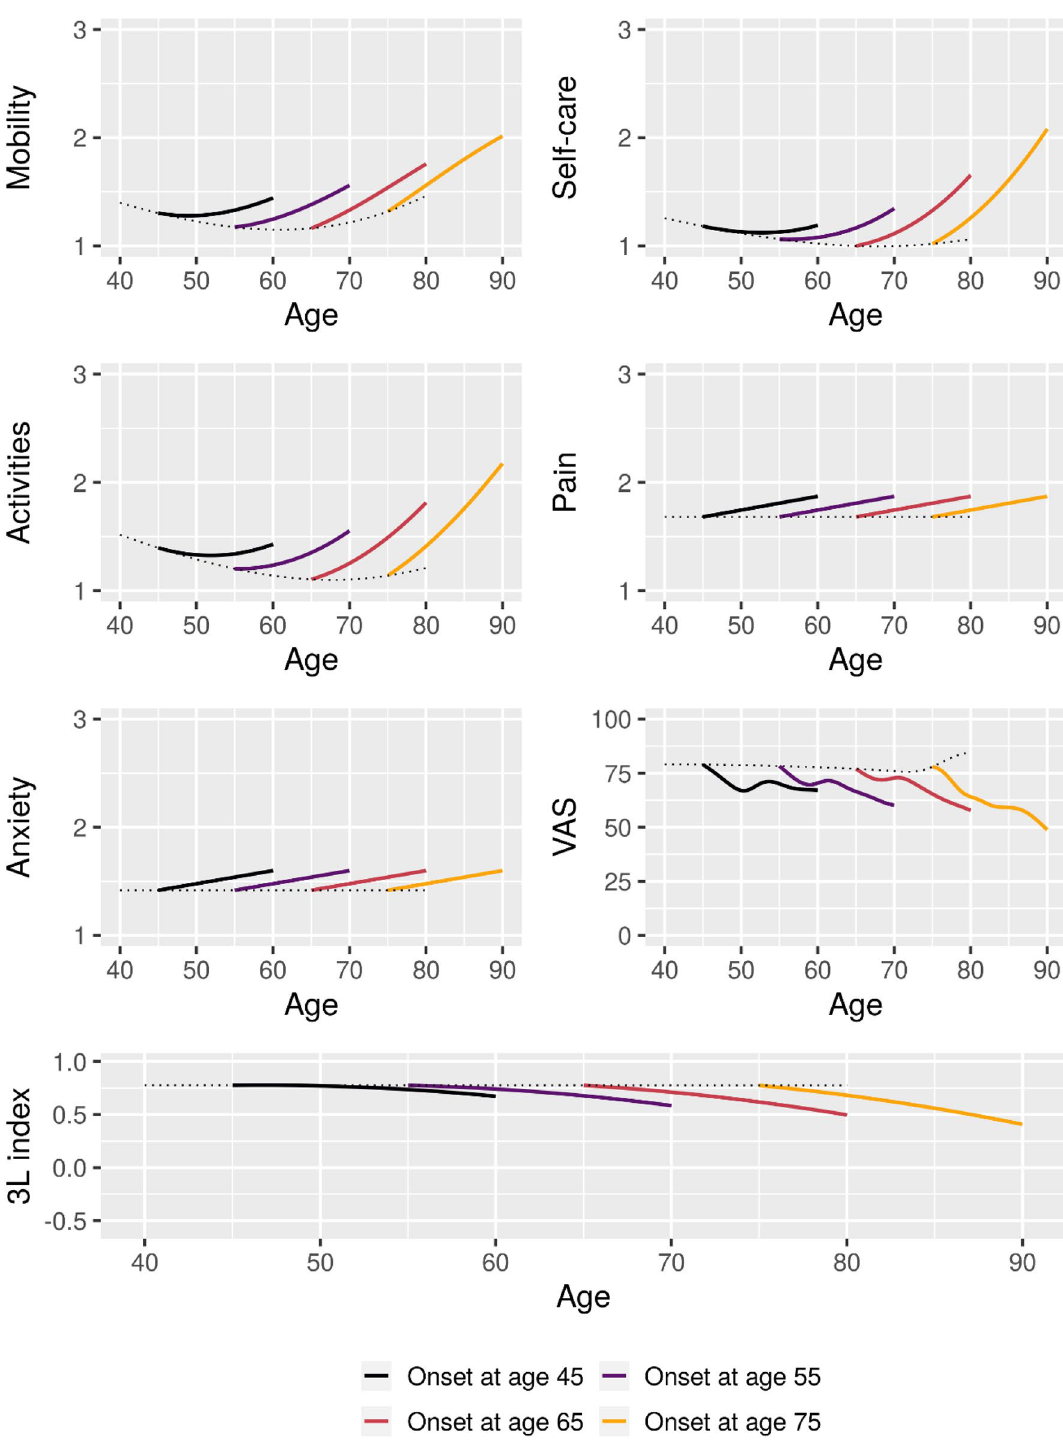
Figure 7. Estimated 15-year mean trajectories of EQ5D-3L outcomes from Parkinson’s disease onset at respectively 45, 55, 65, and 75 years of age. Trajectories estimated based on data from 1800 visits. Dotted line represents the estimated mean scores for patients with onset at the given